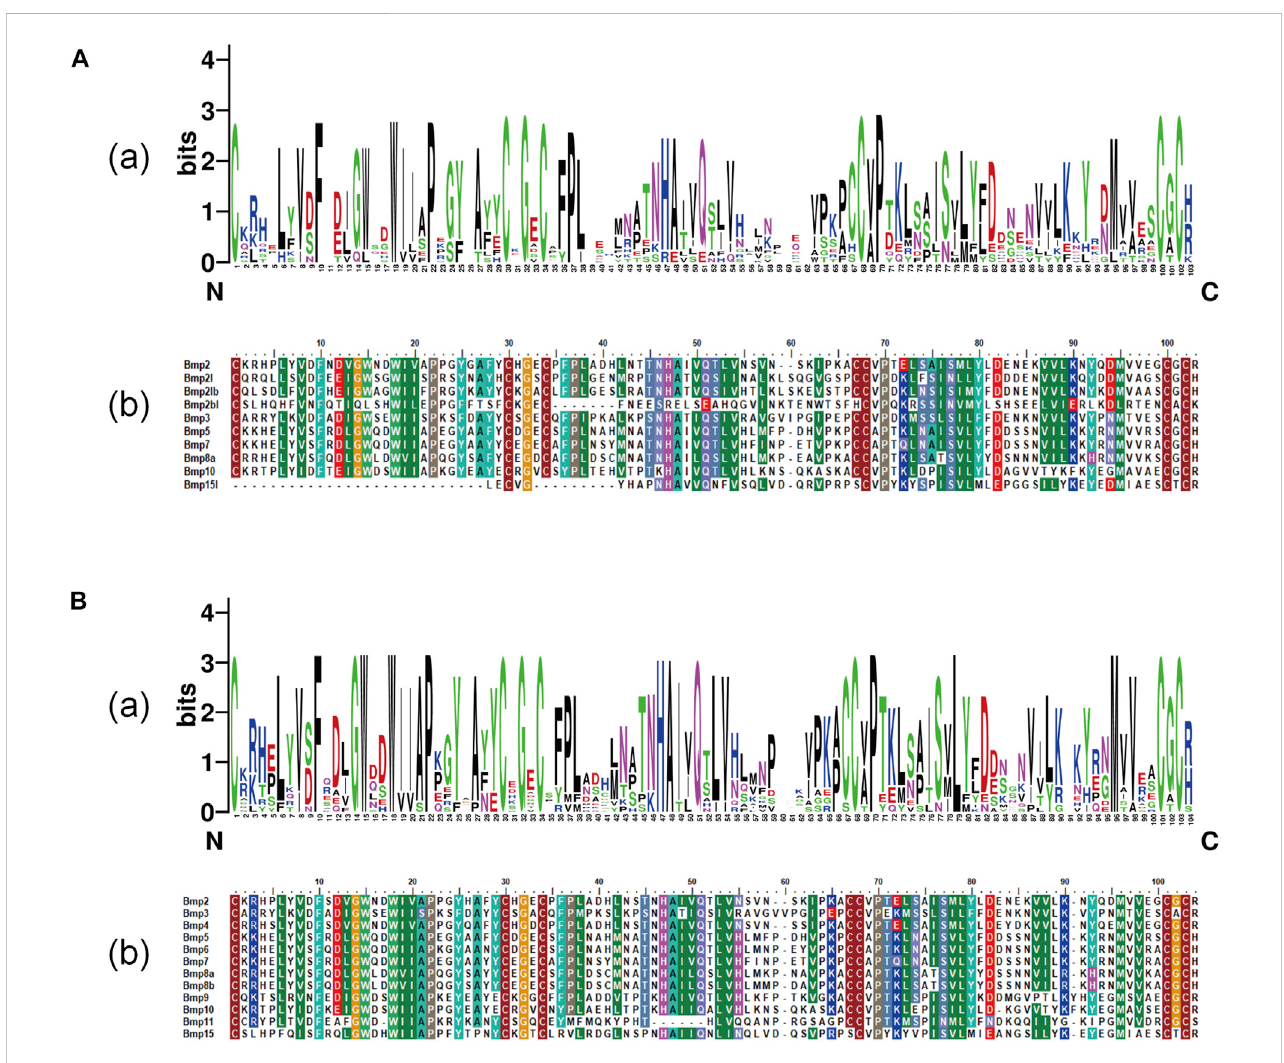
FIGURE 7 MultiplesequencealignmentofTGF- β superfamilydomainsofBMPgenesin P . sinensis (A) and Homo (B) . (A) and (B) showthesequencelogoandamino acid sequence alignment of the TGF- β superfamily domain of BMP genes, respectively. The direction of amino acid sequences is from the N-terminal to the